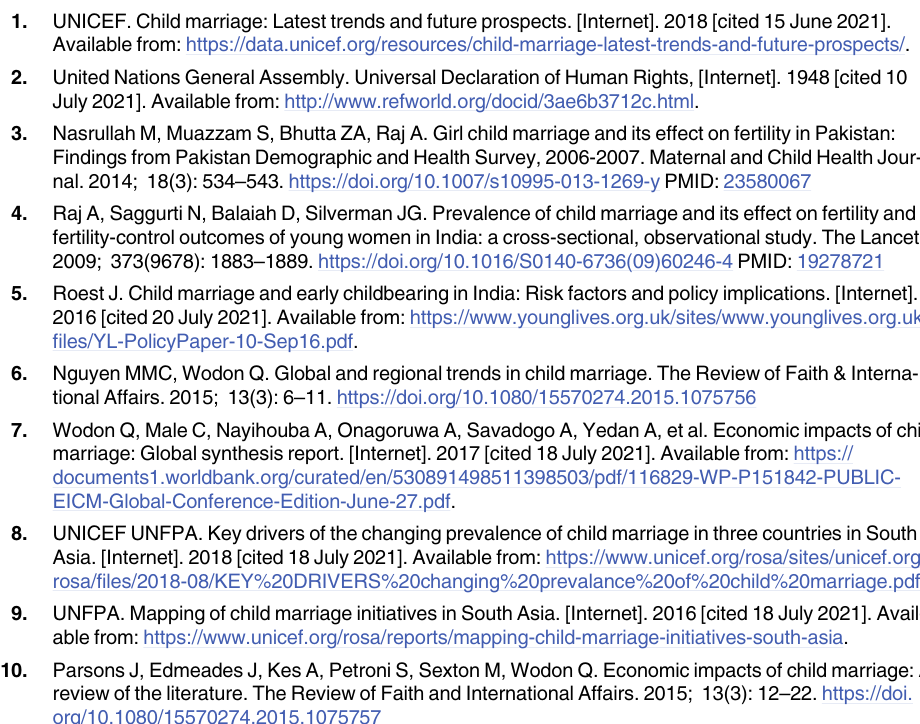
S3 Table. Results with spatially blocked partitioning. S4 Table. Summary of results (with area under precision-recall curve as performance met-